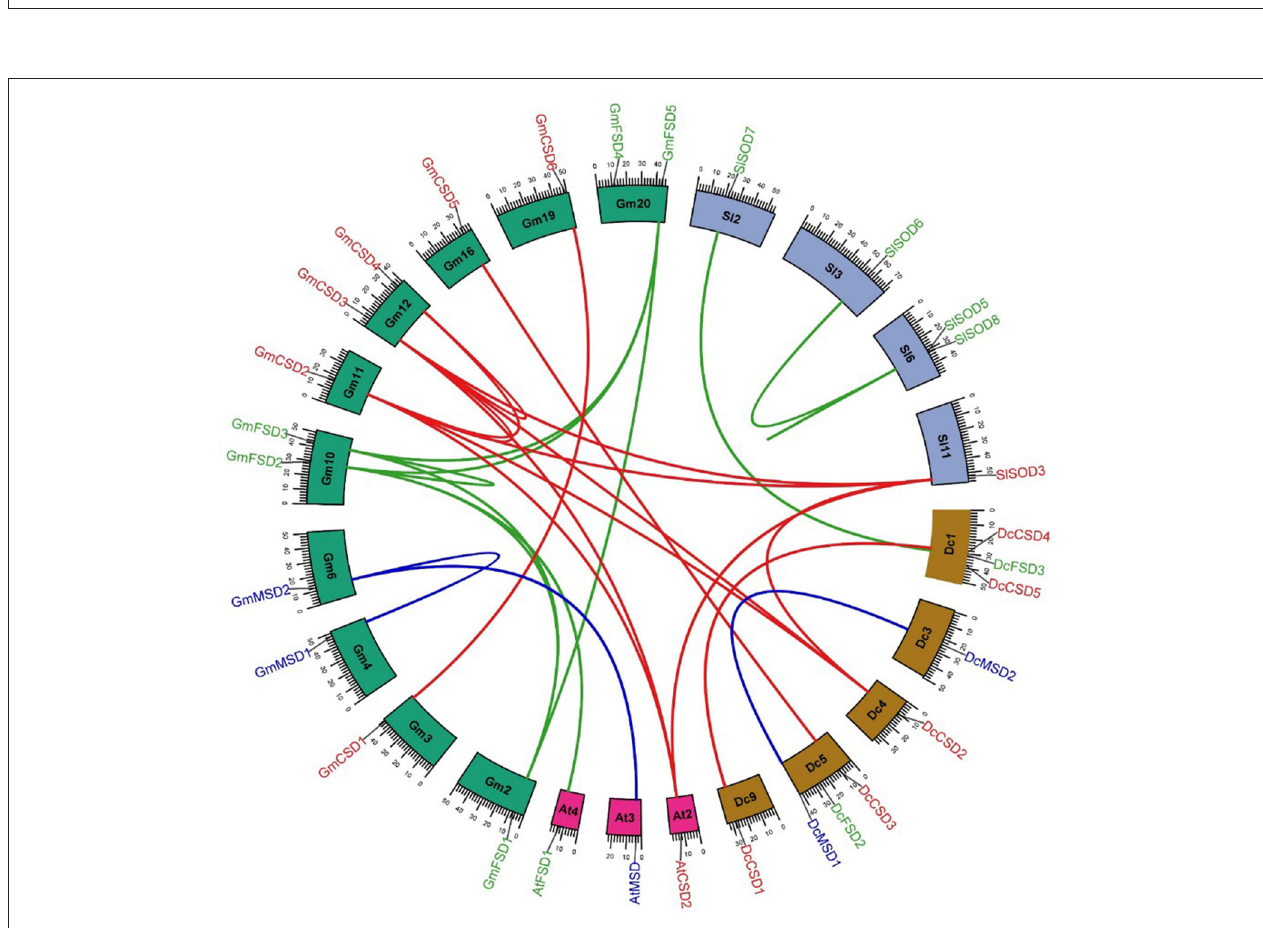
FIGURE 4 | Syntenic analysis of SOD family genes in A. thaliana , D. carota , G. max , S. lycopersicum, and S. bicolor . Blocks are representing the chromosomes and the duplicated genes are connected by lines.